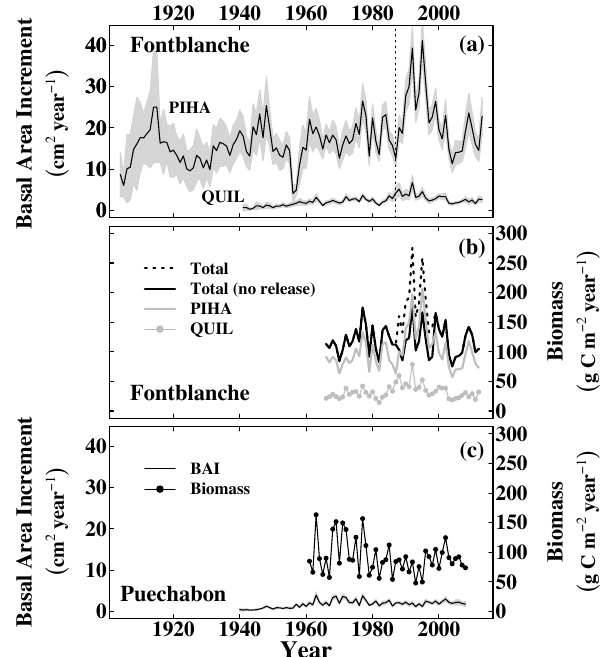
Figure 2. Growth (basal area increment, BAI, cm 2 yr − 1 ) and biomass allocated to the tree stem (gCm − 2 yr − 1 ) of Q. ilex and P. halepensis at Fontblanche (growth shown in a , biomass in b ) and Q. ilex at Puechabon (growth and stem biomass shown in c ). A ver- tical dashed line marks the release event in Fontblanche produced by the enhanced winter mortality in 1985 in (a) . Dark lines for BAI correspond to yearly means while grey polygons show confidence intervals (at 95%) on the standard errors of the